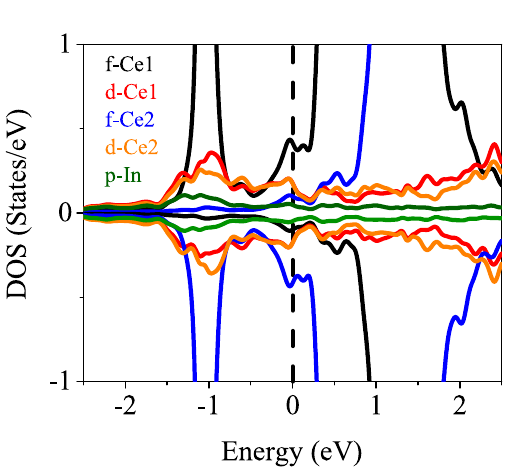
Figure 17. Partial DOSs of CeIn 3 calculated by B3PW91- α = 0.20 at P = 0. The vertical dashed line indicates the Fermi